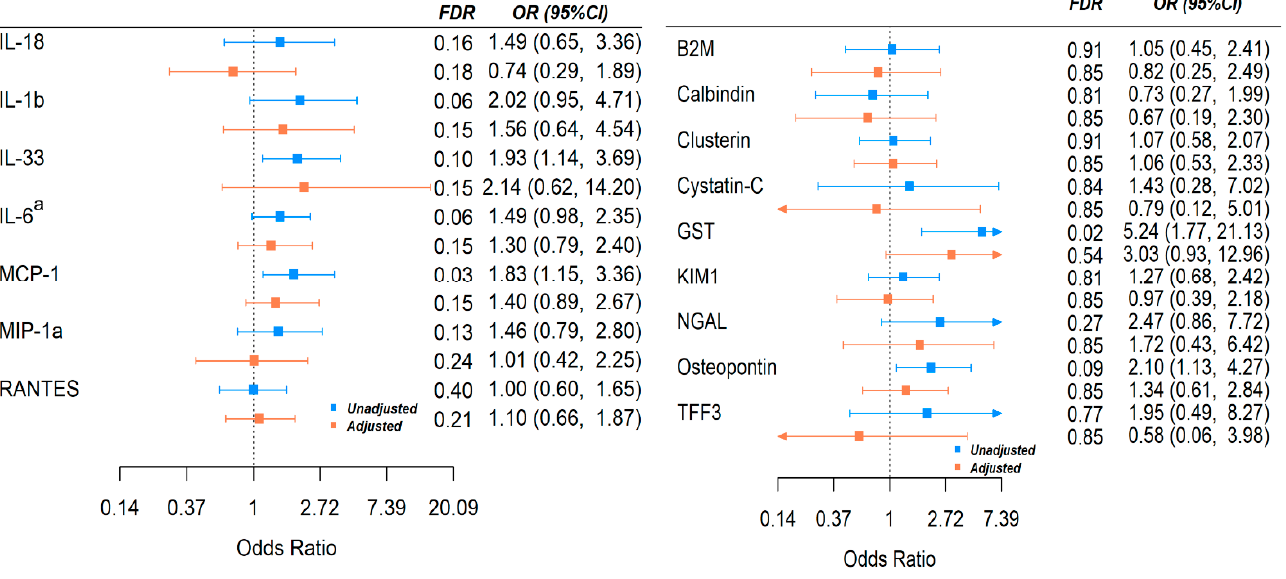
Figure 3. Association of Cytokines with risk of COVID-19 in-hospital mortality before and after adjustment for potential confounders. Adjusted model: dialysis, qSOFA. OR: odds ratio of outcome with 1-fold increase in cytokine levels. a: patients on cytokine inhibitor were excluded for analysis.